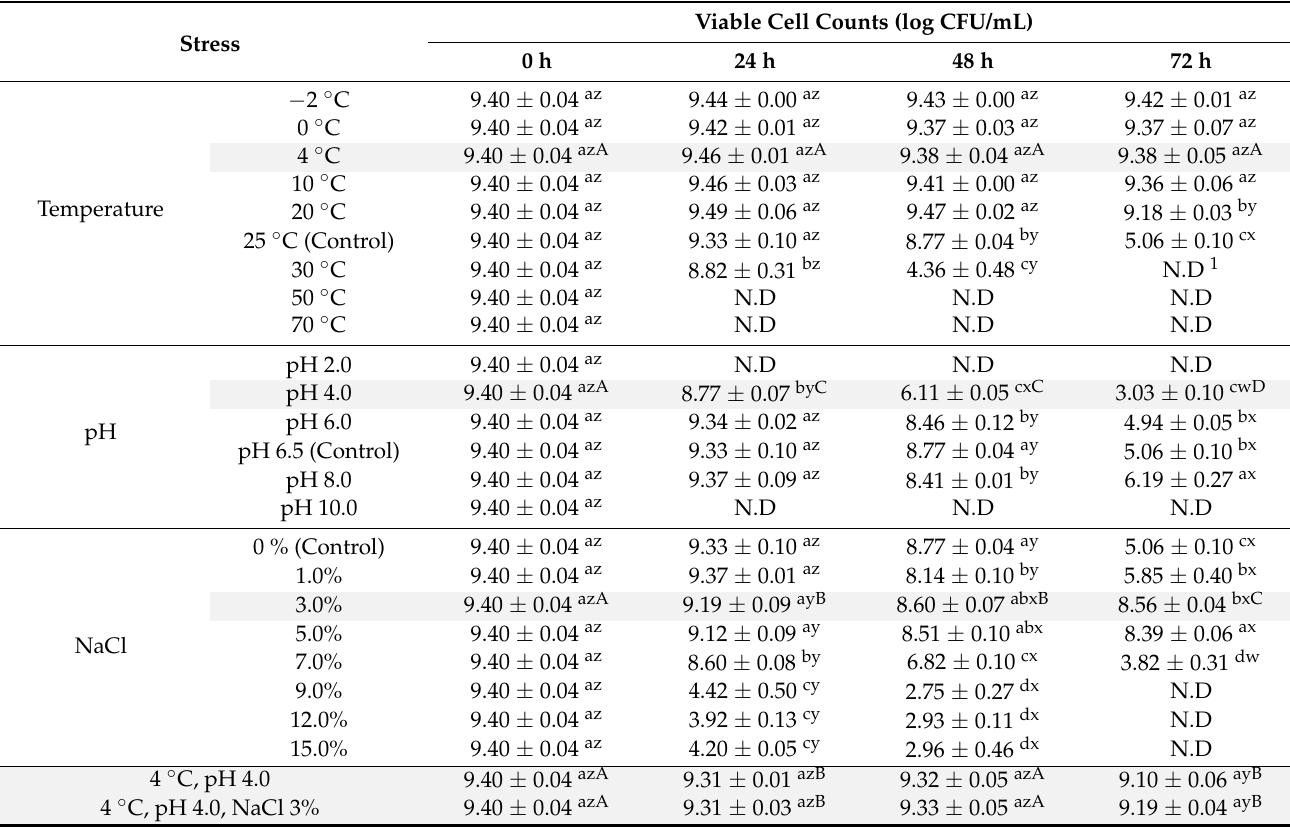
Table 4. Stress tolerance of L. aenigmaticum